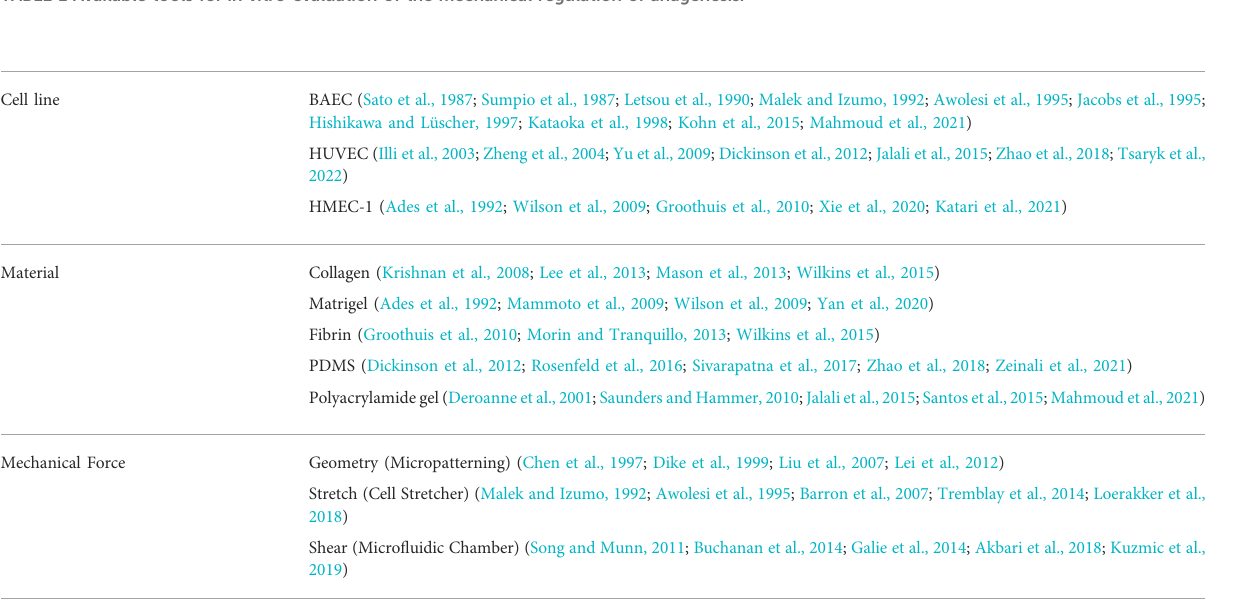
TABLE 1 Available tools for in vitro evaluation of the mechanical regulation of anagenesis.